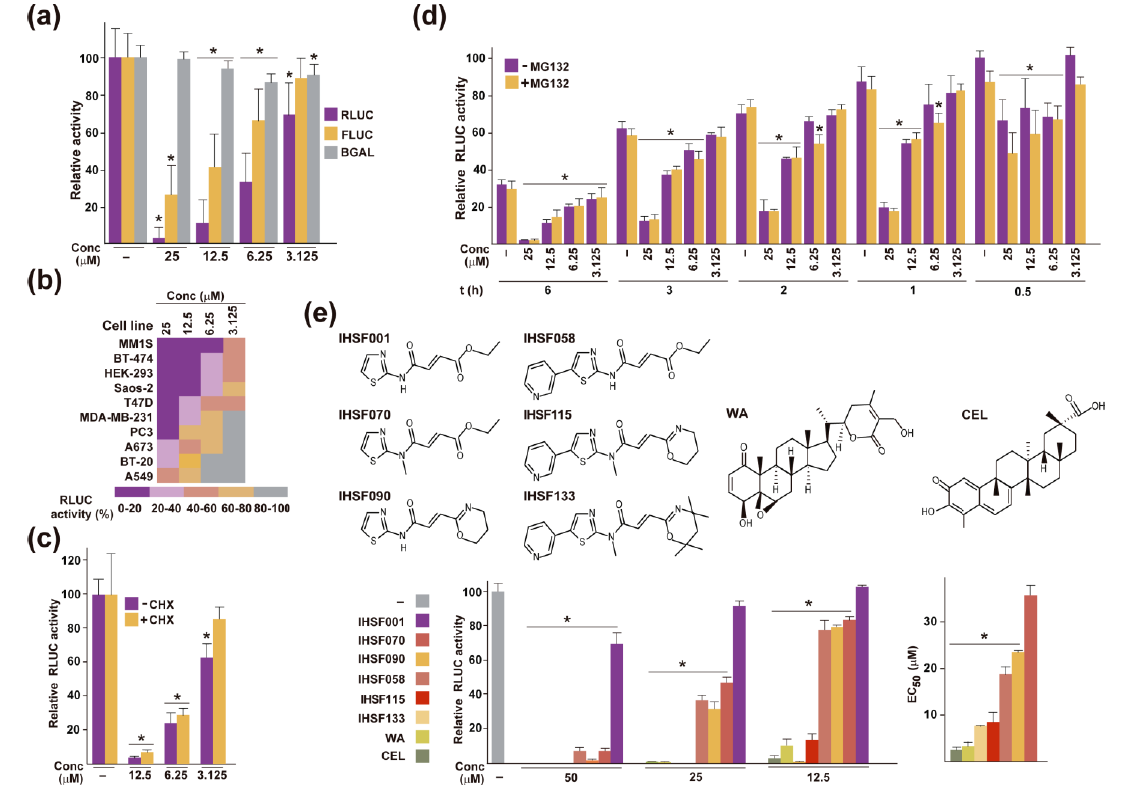
Figure 1. Enhanced inactivation of reporter proteins mediated by IHSF, CEL and WA. ( a ) Parallel cultures of HeLa cells were transfected with reporter constructs pRL-CMV (RLUC), pCMV-Luc (FLUC) or pCMV- βGal (BGAL) using a standard lipofectamine procedure. One day later, the cultures were exposed to the concentrations of IHSF115 indicated in the panel or vehicle (-) for 6 h. Reporter activities were determined as described in Section 4. *: p < 0.05 (compared to cells exposed to vehicle). ( b ) Heatmap depicting RLUC activities in the indicated cell lines after 6 h exposures to different concentrations of IHSF115. Cells were transfected one day prior with pRL-CMV, as in ( a ), except that MM1S cells were transduced with adenoviral construct Ad-CMV-RLUC at an MOI of 100. RLUC activities were determined as in ( a ). ( c ) Parallel cultures of HeLa cells previously transfected with pRL-CMV were exposed for 6 h to the indicated concentrations of IHSF115 or vehicle (-) in the presence or absence of 50 µg/mL cycloheximide (CHX). Transfections and reporter activity determinations were performed as in ( a ). *: p < 0.05 (compared to cells exposed to vehicle). ( d ) Parallel cultures of HeLa cells previously transfected with pRL-CMV were exposed to the indicated concentrations of IHSF115 or vehicle (-) for the indicated times in the presence or absence of MG-132 (10 µM). Transfections and reporter activity determinations were as in ( a ). *: p < 0.05 (compared to cells exposed to vehicle, in the presence or absence of MG-132, at each time point). ( e ) Enhanced inactivation of RLUC caused by different IHSF series compounds, CEL and WA. The structures of the compounds evaluated are depicted at the top. RLUC activities (determined as in ( a )) in M1 cells after 6 h of exposure to the indicated concentrations of compounds or to the common vehicle are shown in the left graph at the bottom. *: p < 0.05 (compared to cells exposed to vehicle). IC50 values (50% reduction in RLUC activity relative to the control after a 6 h exposure) were 67.8 +/− 19.5 µM for IHSF001, 20.4 +/− 7.0 µM for IHSF058, 20.4 +/− 7.3 µM for IHSF070, 16.6 +/− 2.5 µM for IHSF090, 10 .0 +/− 0.9 µM for WA, 9.0 +/− 3.8 µM for IHSF115 , 4.5 +/− 2.0 µM for CEL and 2.4 +/− 0.5 µM for IHSF133. EC50 values (50% viability after a 96 h of exposure to compound relative to a control exposure to vehicle) estimated by alamar blue assay are shown in the right graph at the bottom. EC50 of IHSF001 could not be calculated as the viability of cells treated at 50 µM was only reduced by 3.8%. *: p < 0.05 (compared to cells exposed to IHSF070).